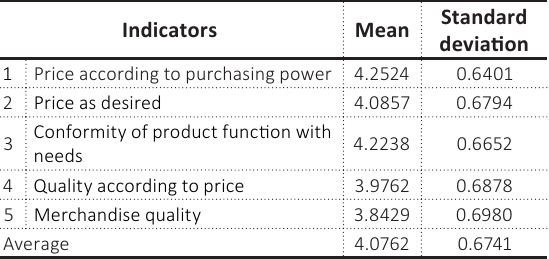
Table 3. Mean score for product attributes